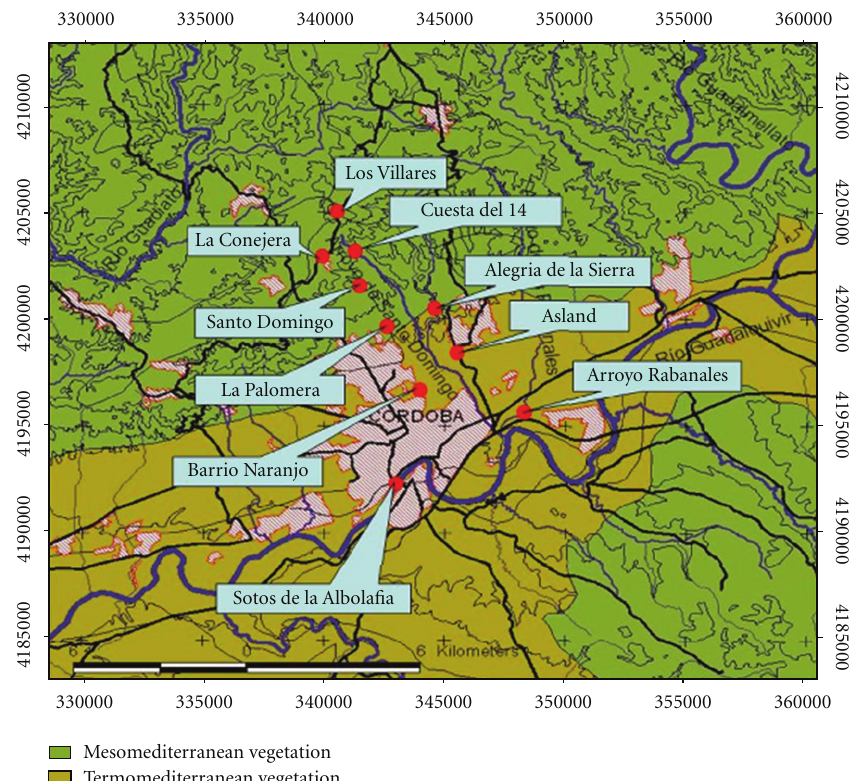
Figure 1: Sampling points